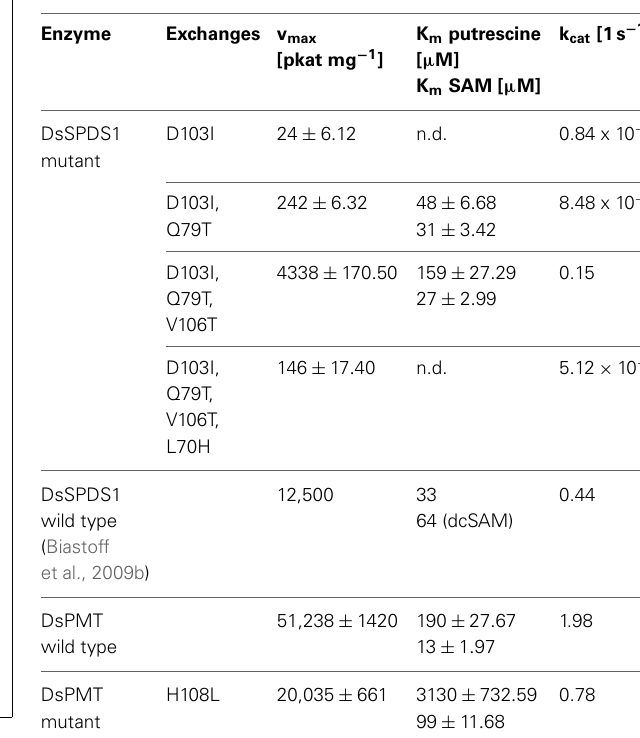
Table 4 | PMT activities of DsSPDS1 and DsPMT mutants; DsSPDS1 wild type and DsPMT wild-type activities for